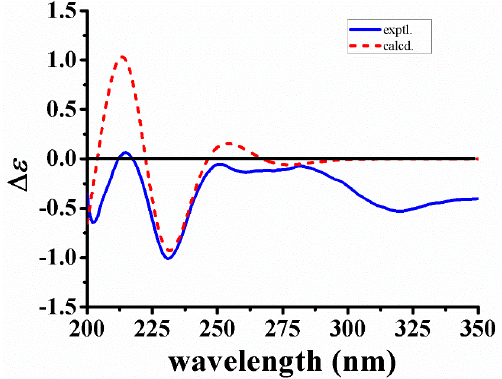
Figure 4. Calculated and experimental CD spectra of 1 .